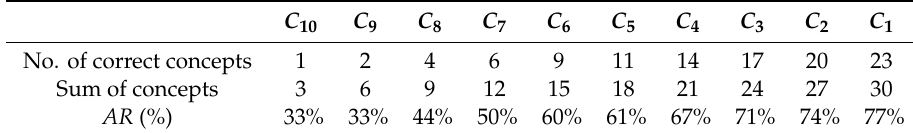
Table 9. Learning achievement results for student 2, who correctly answered Q 1 – Q 12 , Q 14 – Q 20 , Q 22 – Q 23 , Q 26 , and Q 28 .